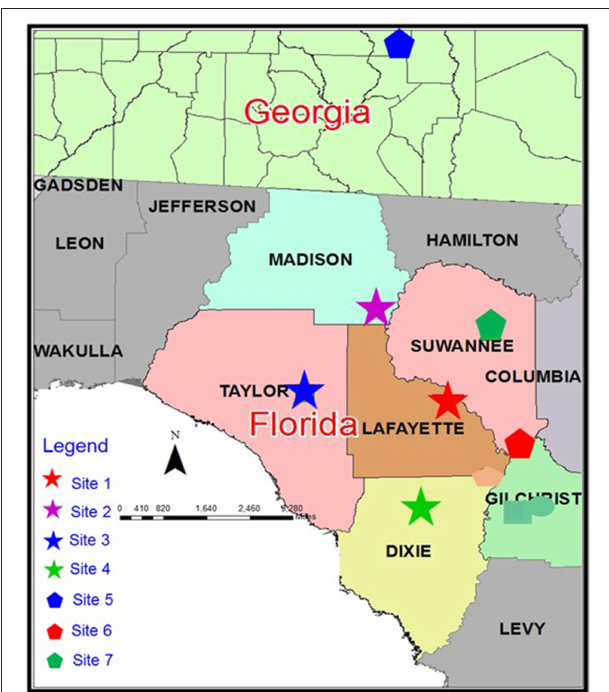
FIGURE 1 | Location of the study sites. Sites 1–4 were sampled for Protocol Development and Sites 5–7 were sampled for Protocol Testing 1. All sites were sampled (different locations within the sites) in a subsequent year for Protocol Testing